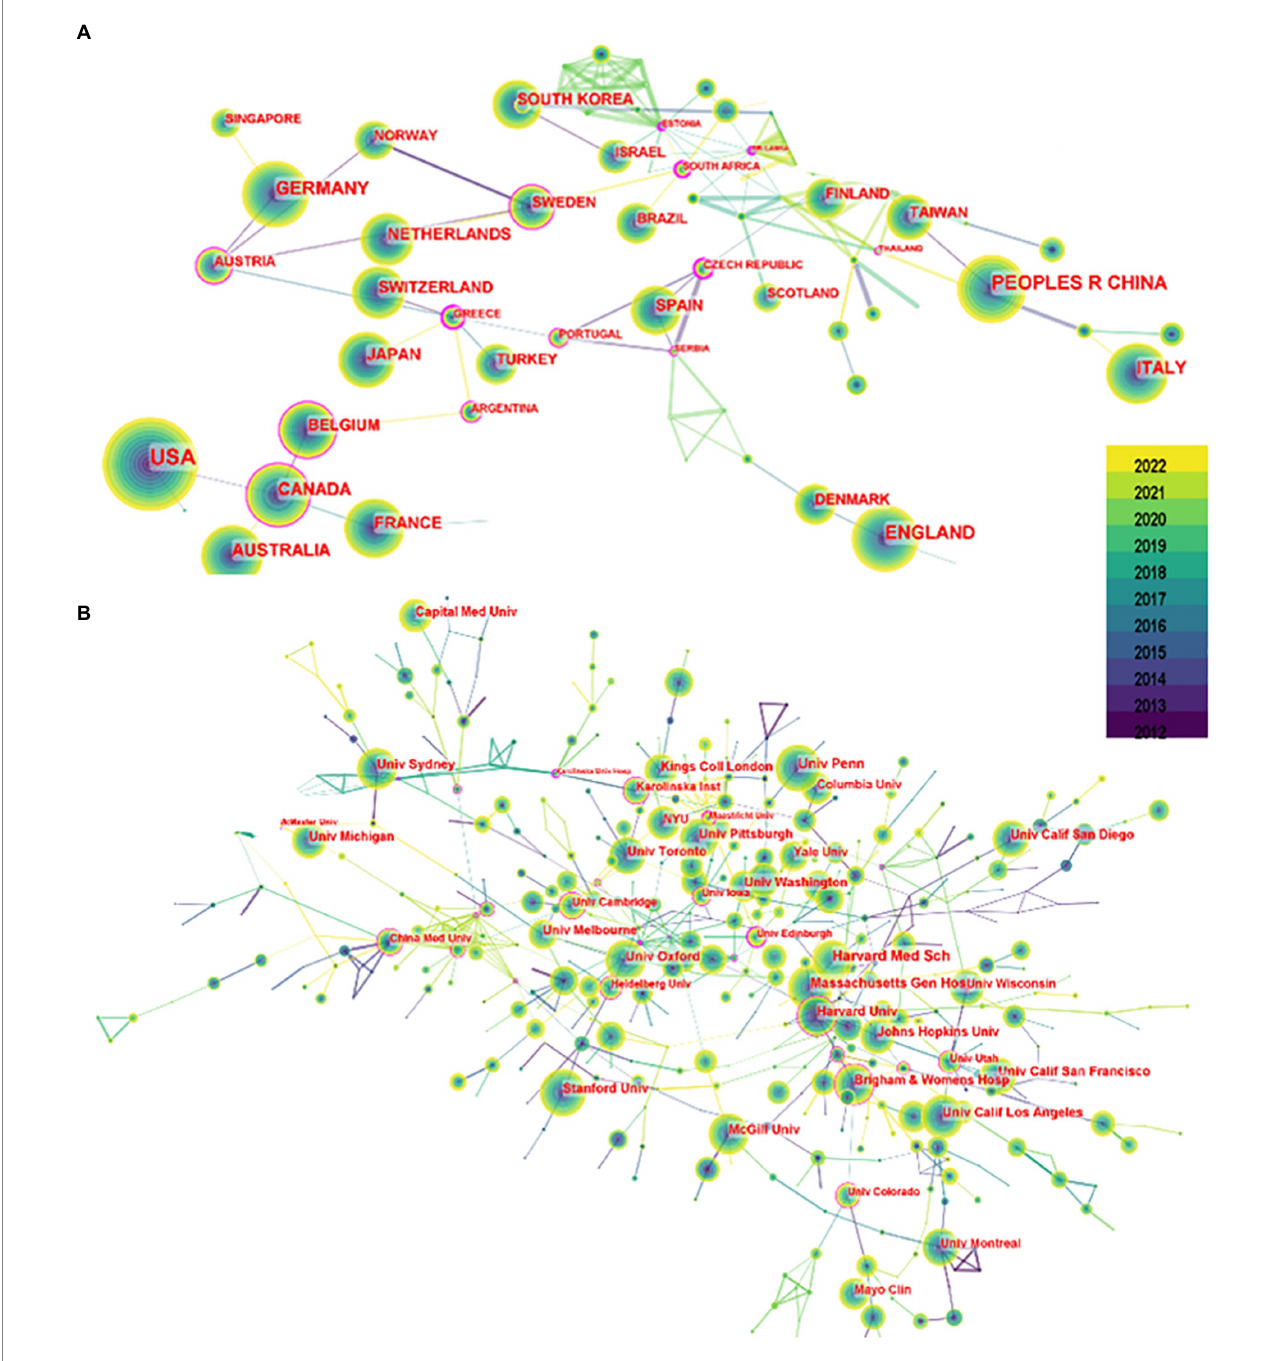
FIGURE 3 Mapping of issuing countries and institutions. (A) Shows the country/region from which publications issued, and (B) shows the issuing institution. Each circle in the figure represents a country, with the circle’s size indicating that country’s publication output. The lines connecting the circles represent international cooperation: the thicker the line, the closer the cooperation. The purple outer circle in the figure indicates centrality ≥